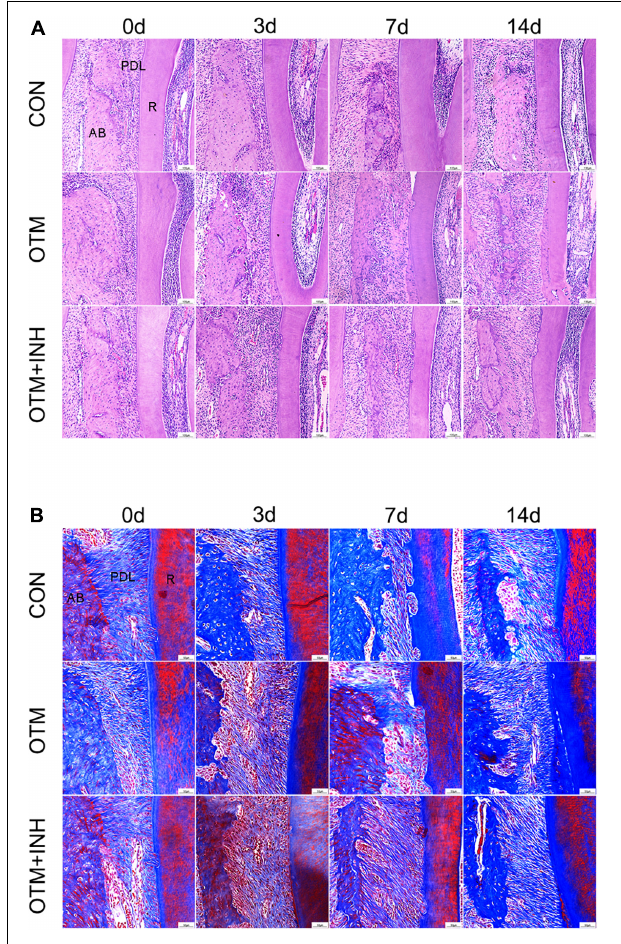
FIGURE 3 | Histological changes of PDL on the tension side of the distobuccal roots. HE staining (A) and Masson’s trichrome staining (B) of PDL. Periodontal fibers were stretched by applying orthodontic force in the OTM group, while remodeling was delayed by the inhibitor of Piezo1 in the OTM + INH group. Scale bar for (A) = 100 µ m. Scale bar for (B) = 50 µ m. AB, alveolar bone; R,